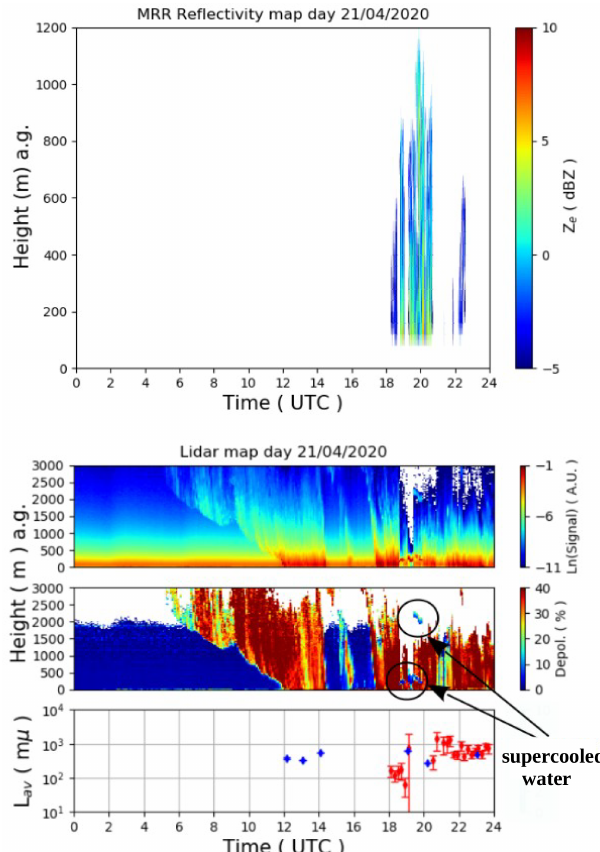
Figure 23. As for Fig. 17 but for the day of 21 April 2020.